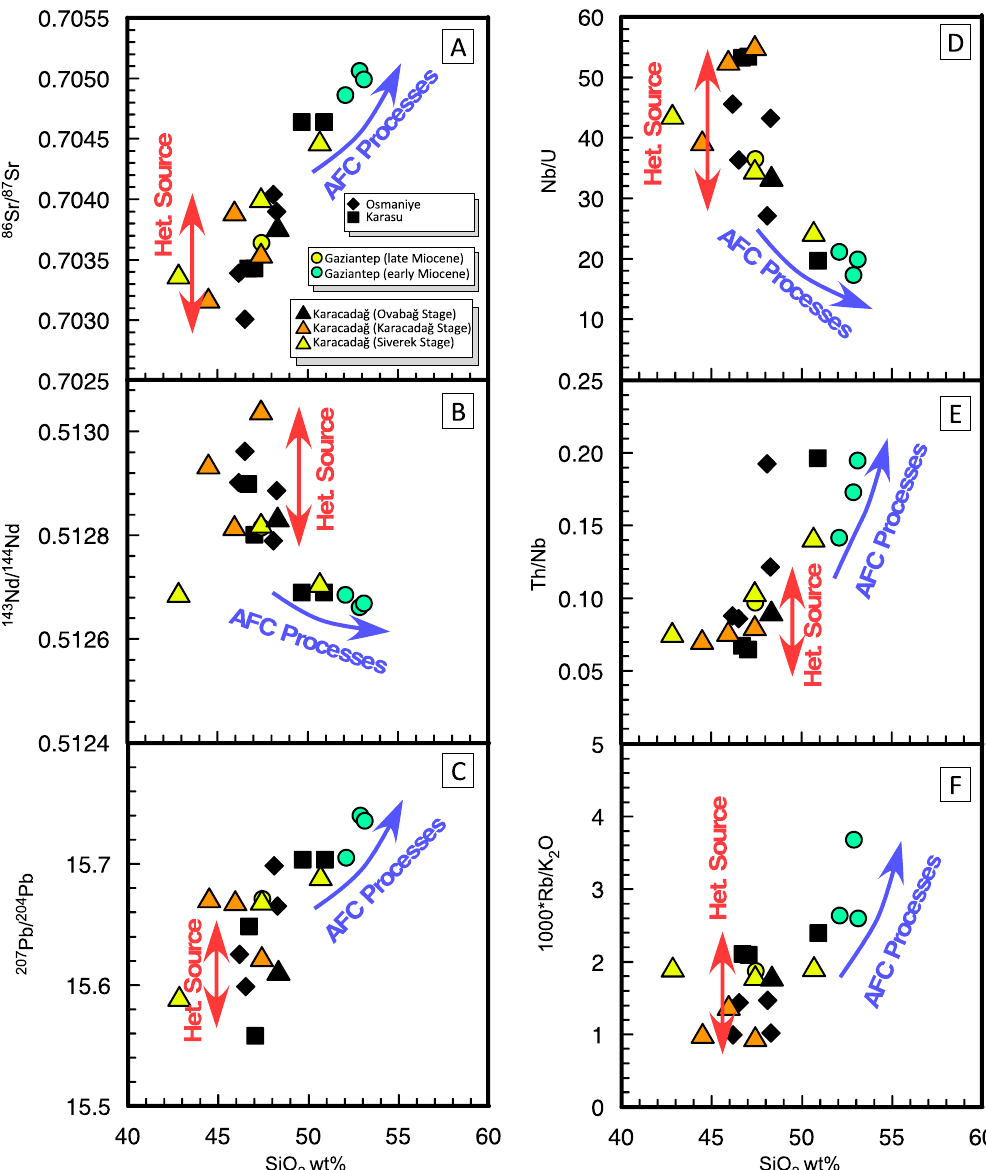
Figure 5. Variations in radiogenic isotope and trace element ratios due to mantle heterogeneity or crustal contamination. ( A – C ) 87 Sr/ 86 Sr, 143 Nd/ 144 Nd, and 207 Pb/ 204 Pb vs. SiO 2 ; ( D – F ) Nb/U, Th/Nb, and 1000*Rb/K 2 O vs. SiO 2 diagrams. Red arrows indicate variation due to source heterogeneity, blue arrows indicate variation due to open-system magma evolution (i.e. assimilation plus crystal fractionation